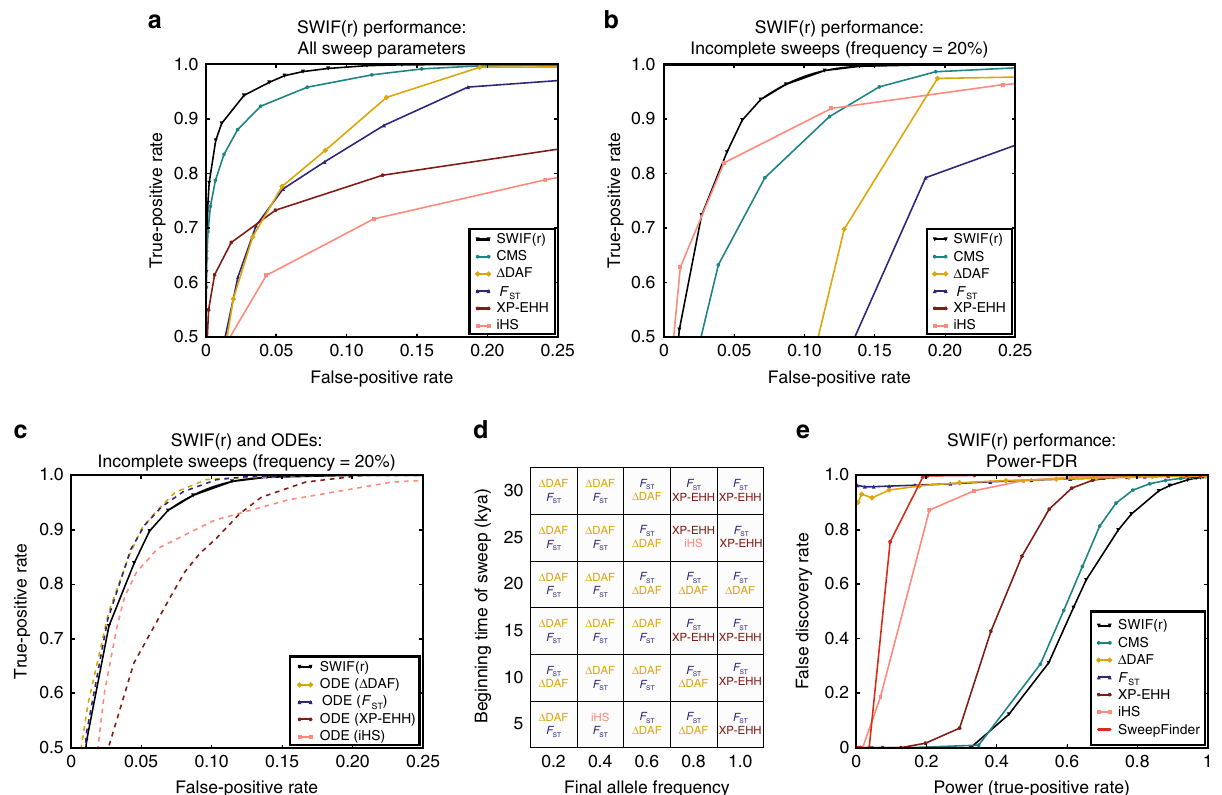
Fig. 1 SWIF(r) outcompetes existing site-based sweep-detection methods for a range of sweep model parameters. For comparison against window-based sweep-detection methods, see Supplementary Figs. 9 and 10. a Receiver operating characteristic (ROC) curves comparing SWIF(r) with CMS 9 , F ST , iHS, XP-EHH, and Δ DAF across all simulated neutral and sweep scenarios (see Methods). False-positive rate is the fraction of simulated neutral sites that are incorrectly classi fi ed as adaptive, and the true-positive rate is the fraction of simulated sites of adaptive mutations that are correctly classi fi ed. SWIF(r) constitutes an improvement in the tradeoff between true and false positives. SweepFinder 4 is not visible here or in b (Supplementary Fig. 6). b ROC curves for incomplete sweeps in which the bene fi cial allele has a population frequency of 20%. SWIF(r) reduces the false-positive rate by up to 50% relative to CMS. c ROC curves for SWIF(r) and the four component ODEs for incomplete sweeps in which the bene fi cial allele has a frequency of 20%. Since the AODE is an average of the ODEs, there will always be individual ODEs that match or outperform SWIF(r); in this case, the ODEs conditioned on F ST and Δ DAF both achieve this. d The two highest-performing ODEs for different sweep parameters. Performance is de fi ned as area under the ROC curve. The statistic that leads to the highest-performing ODE is listed fi rst in bold, followed by the second best. Colors correspond to ROC curves in panels a – c . While ODEs conditioned on Δ DAF tend to perform extremely well for sweeps that are at lower frequency, ODEs conditioned on F ST and XP-EHH tend to perform better for sweeps that are near-complete or complete in the population of interest. By averaging the ODEs, SWIF(r) is robust to uncertainty about the true parameters of the sweep. e Power-FDR curves for SWIF(r), CMS, F ST , iHS, XP-EHH, Δ DAF, and SweepFinder. Power is equivalent to true-positive rate as de fi ned in a – c , and false discovery rate is de fi ned as the fraction of sites classi fi ed as adaptive that are actually neutral. These curves assume a training set composed of 99.95% neutral variants and 0.05% adaptive variants. See Supplementary Fig. 11 for curves based on other training set SWIF(r) does bene fi t from the inclusion of cross-population statistics, while both evolBoosting and evoNet rely on component statistics de fi ned for single populations.